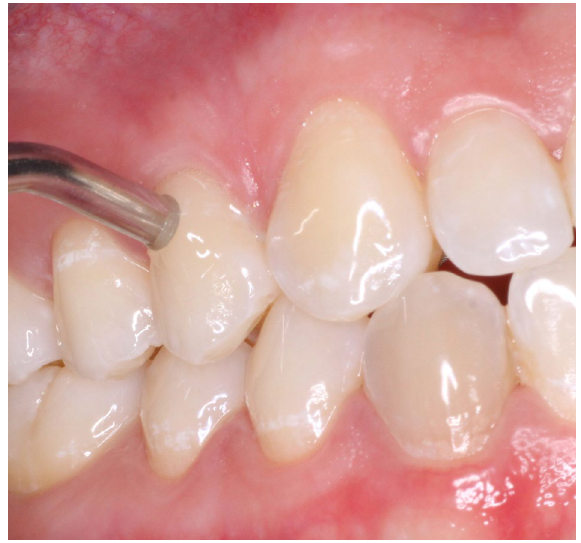
Figure 3. Application of the electrode tip onto the buccal test tooth surface using fluoride gel as conduction medium.